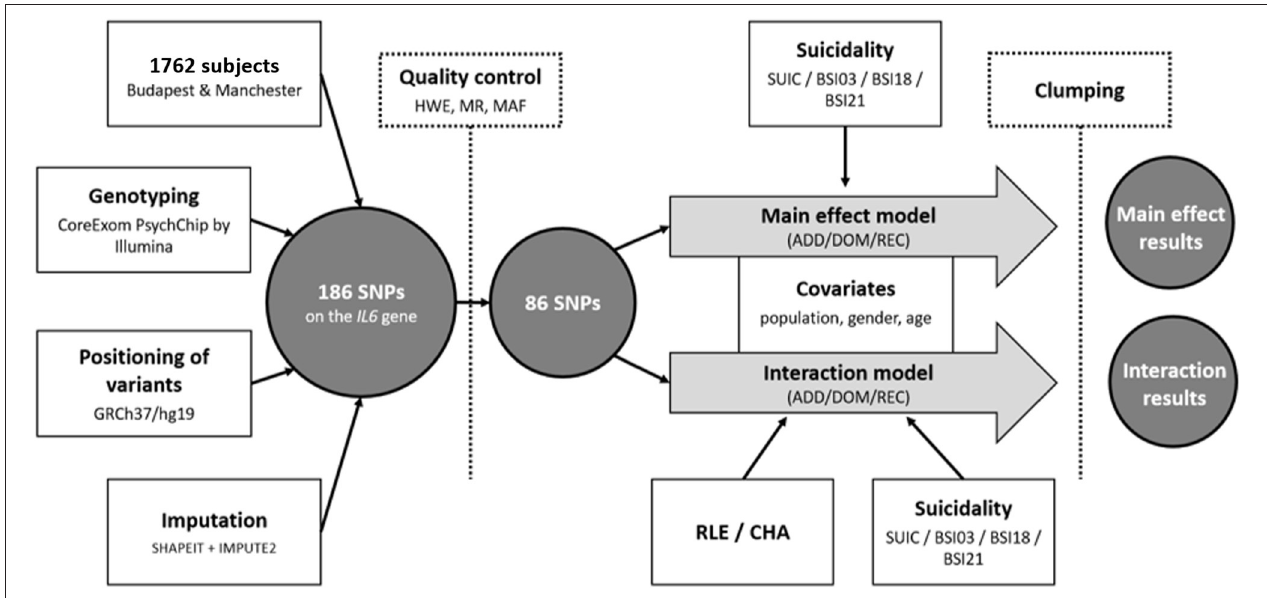
FIGURE 1 | Sample, methodology and statistical analyses used to investigate effect of IL6 gene variations on lifetime suicide attempts (SUIC) and suicide items of the Brief Symptom Inventory (BSI) both in main effect models and in interaction with proximal (recent negative life events) and distal (childhood adversities) stressors. SNP, Single Nucleotide Polymorphism; SUIC, lifetime suicide attempts; BSI, Brief Symptom Inventory; SI-BSI03, current suicidal ideation (“Thoughts of ending your life”); H-BSI18, current hopelessness (“Feeling hopeless about the future”); ToD-BSI21, current thoughts of death (“Thoughts about death and dying”); RLE, Recent negative Life Events; CHA, Childhood Adversity; HWE, Hardy-Weinberg Equilibrium; MR, Missing Rate; MAF, Minor Allele Frequency; ADD, additive model; DOM, dominant model; REC, recessive model.